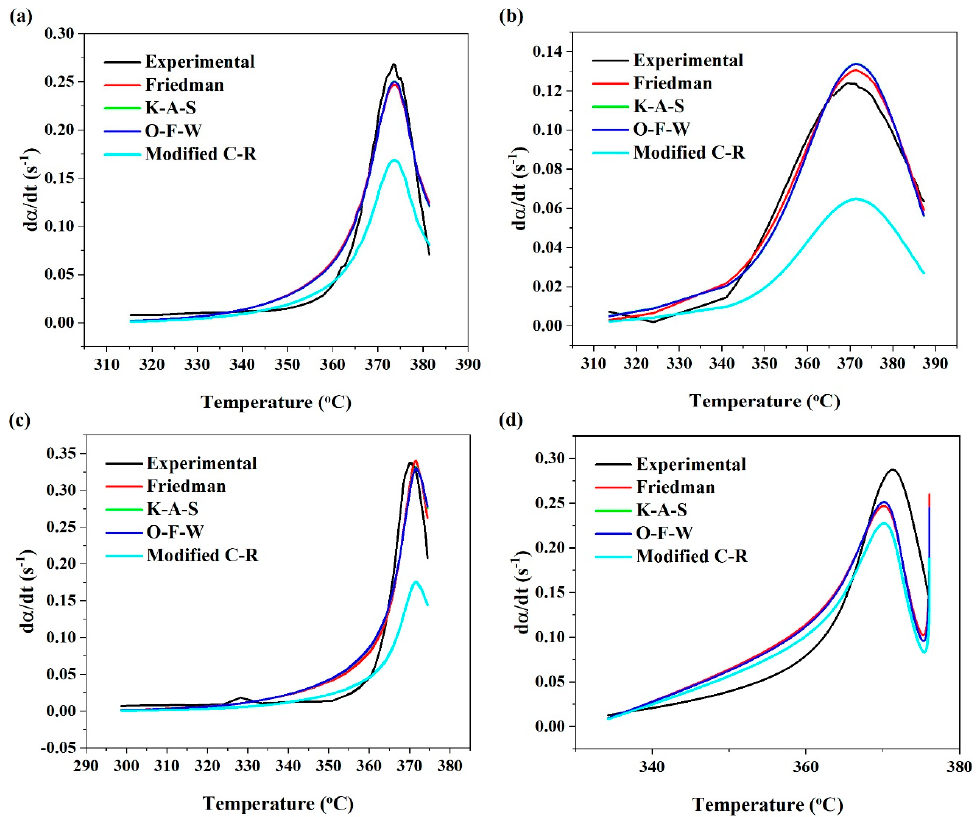
Figure 9. Predicted kinetics plots based on the Sestak and Berggren decomposition reaction model for blank PU and its nanocomposites containing various V-ZrO 2 loadings at the heating rate of 5 °C·min − 1 : ( a ) Blank PU; ( b ) PU/V-ZrO 2 -1; ( c ) PU/V-ZrO 2 -3; and ( d ) PU/V-ZrO 2 -5. ( a ) Blank PU; ( b ) PU / V-ZrO 2 -1; ( c ) PU / V-ZrO 2 -3; and ( d ) PU / V-ZrO 2